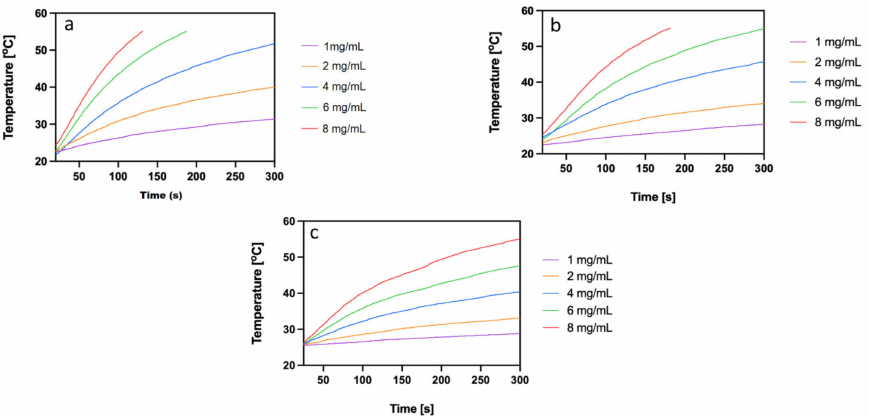
Figure 5. Heating of SPION: ( a ) coated with citrate, ( b ) SPION@Au, and ( c ) SPION@Au–PEG nanoparticles in alternating magnetic fields.